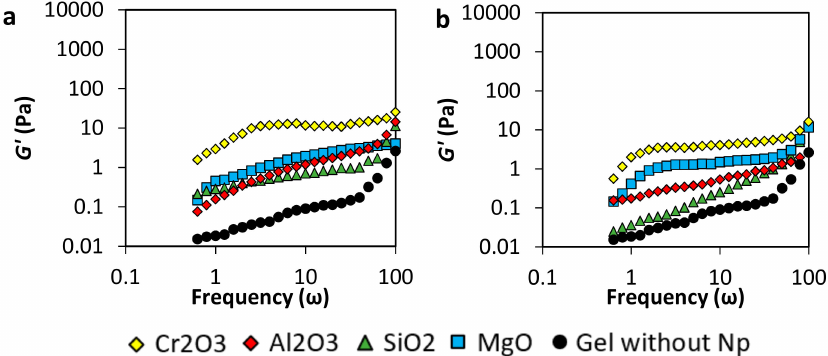
Figure 5. Storage moduli of acrylamide / sodium acrylate copolymer / chromium III acetate gel system at dosages of ( a ) 50 mg · L − 1 and ( b ) 20 mg · L − 1 of Al 2 O 3 , MgO, Cr 2 O 3 , SiO 2 nanoparticles, a polymer concentration of 4000 mg · L − 1 , and 70 ◦